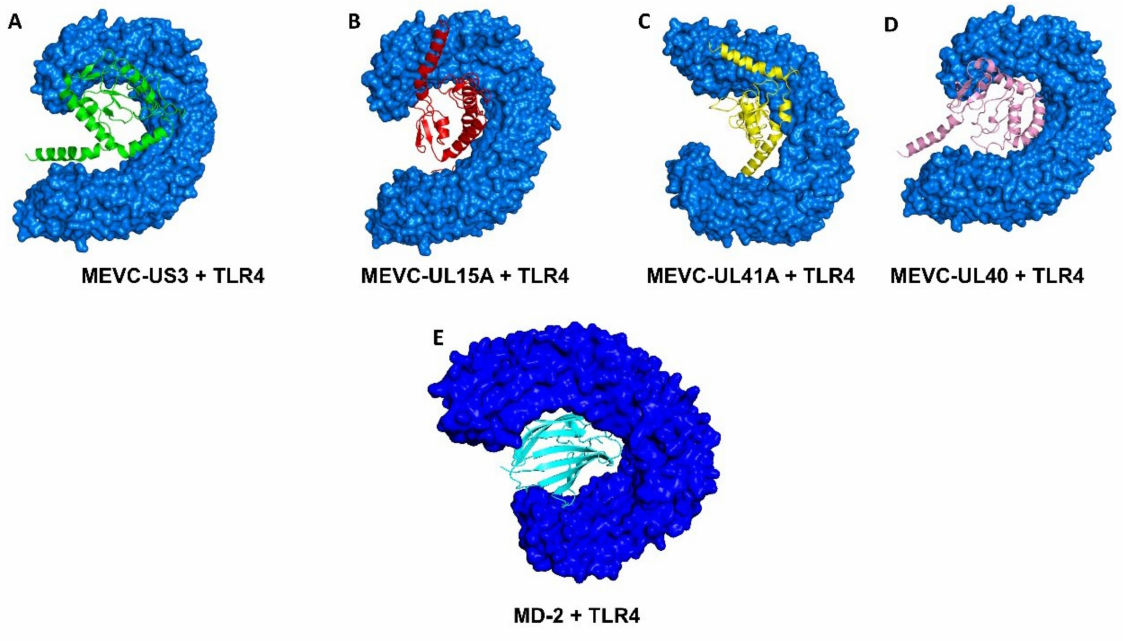
Figure 4. ( A – E ) Represents the docking complexes of final multi-epitope-based vaccine designs with human TLR-4 for each of the target HCMV protein.